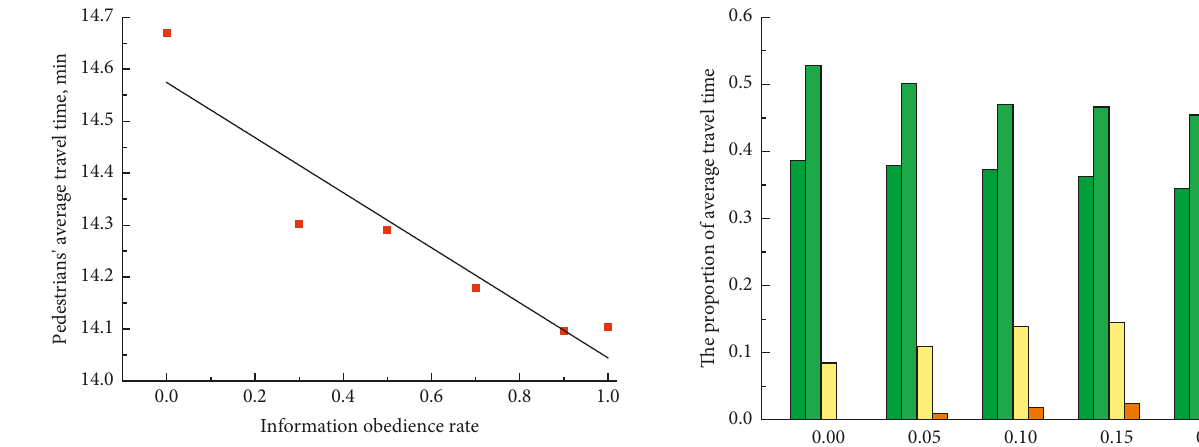
Figure 10: The pedestrians’ average travel time under different information obedience rates.